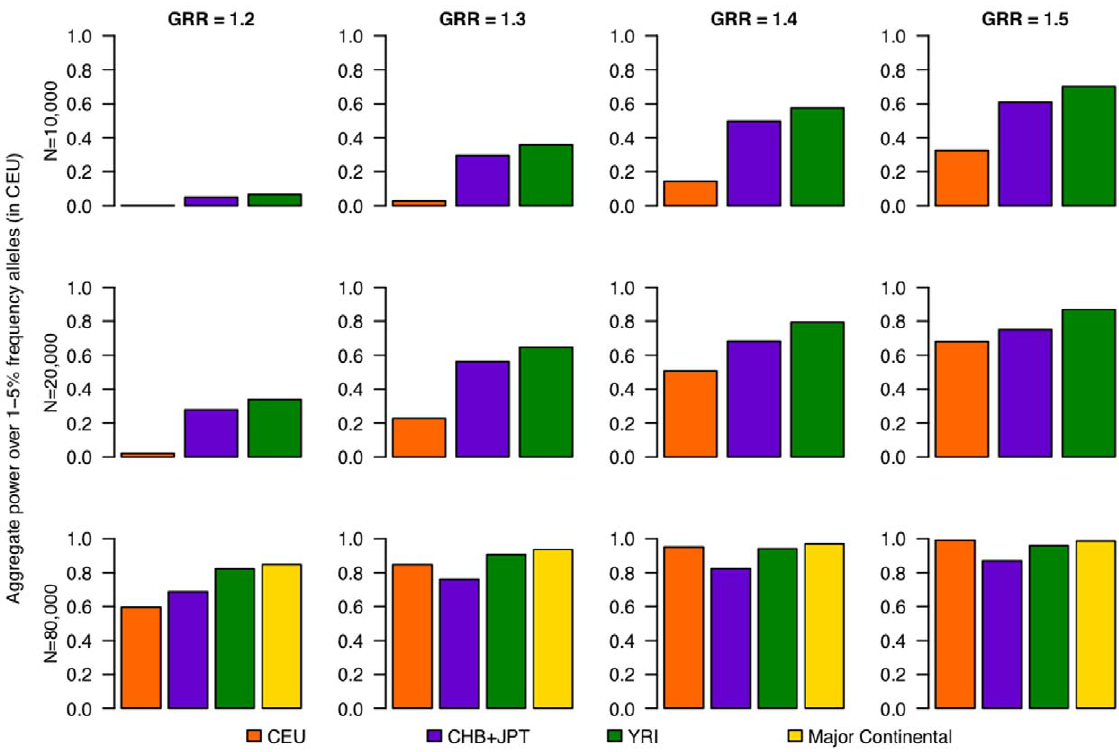
Figure 3. Power to detect association for lower-frequency alleles ( # 5%) in CEU using 1000 Genomes Project data. Power is given for three individual panels (CEU, CHB + JPT, YRI), and a multiethnic panel (CEU + CHB + JPT + YRI) in phase 2, aggregated over those alleles that have lower frequency (1–5%) in CEU.